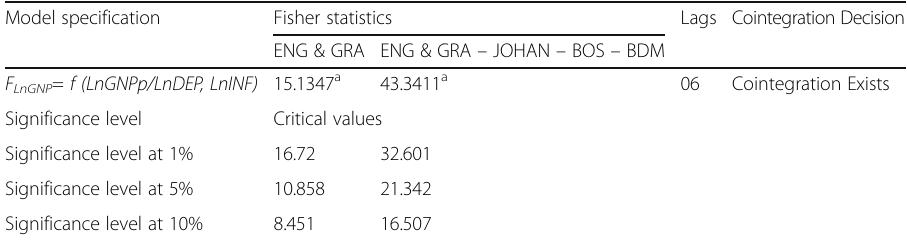
Table 8 Bayer – Hanck cointegration test